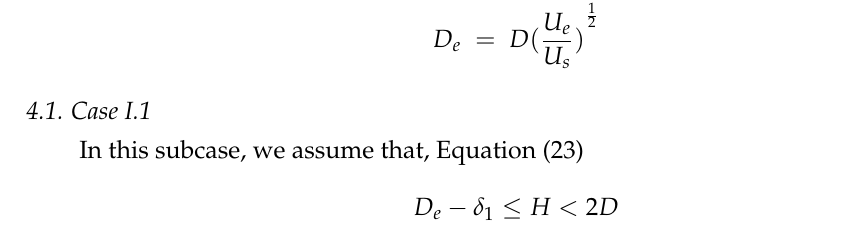
Cross- Sectional Profile after